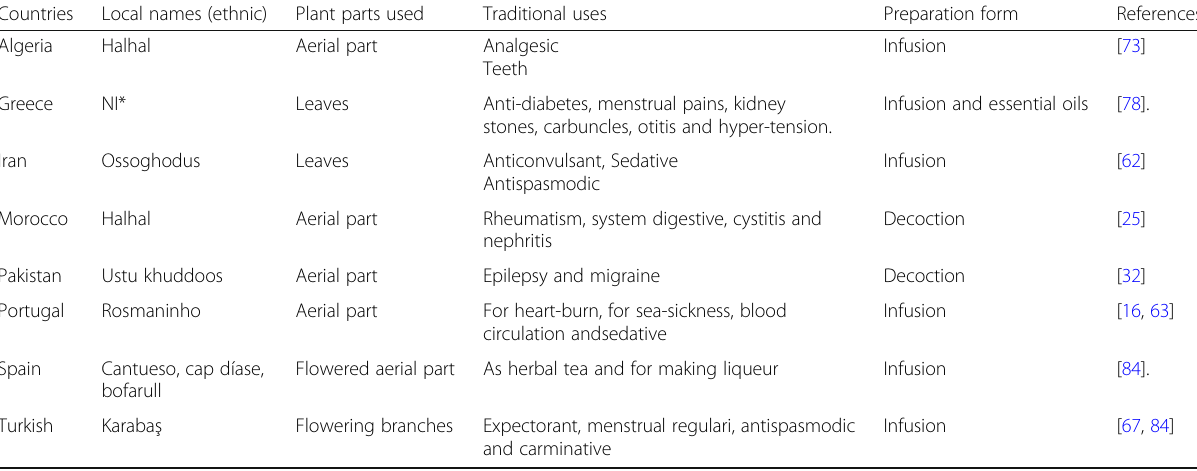
Table 1 Ethnomedicinal uses of L. stoechas in some Mediterranean countries Countries